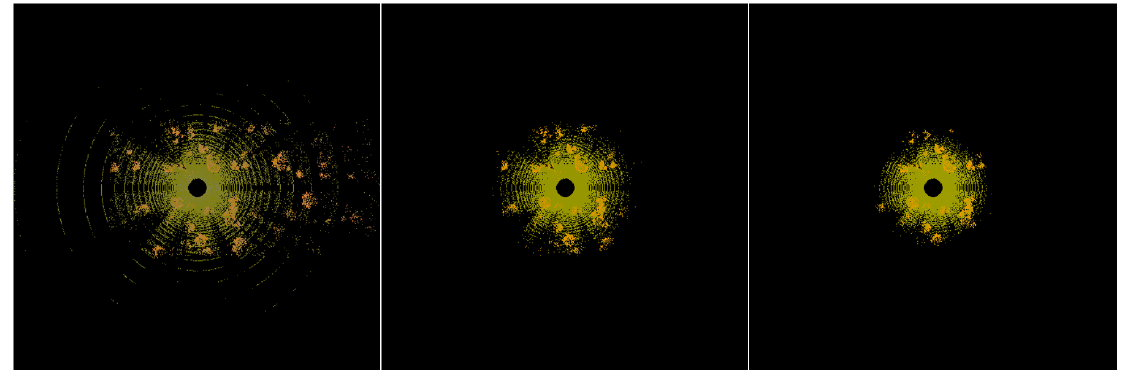
Figure 6. Obstacle detection range as a function of rain rate.